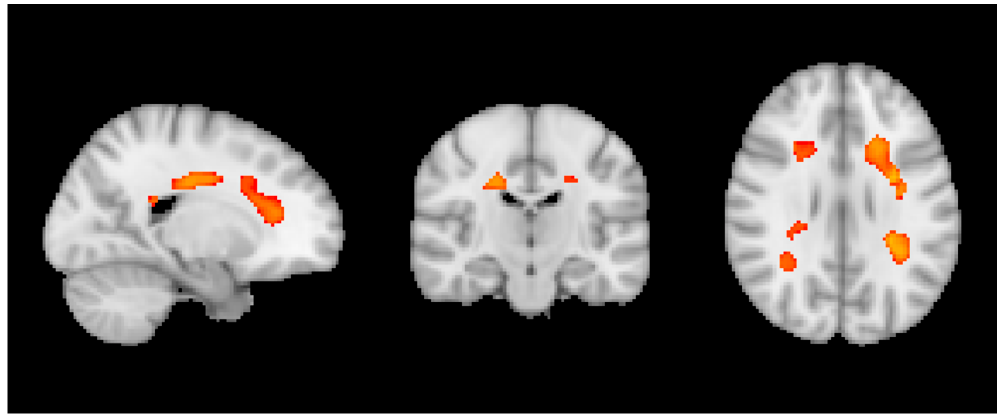
Figure 1. Negative correlation between wine and VBM across all individuals. p < 0.05 TFCE corrected.